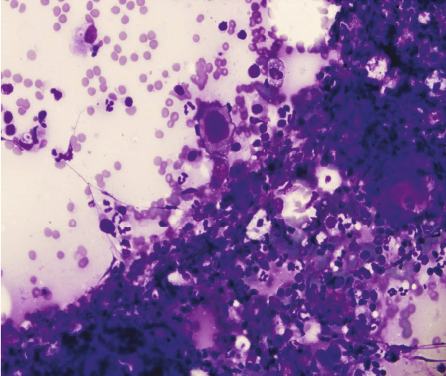
Figure 3: Right paratracheal lymph node biopsy via EBUS-TBNA showing Reed–Sternberg cells (Diff-Quick